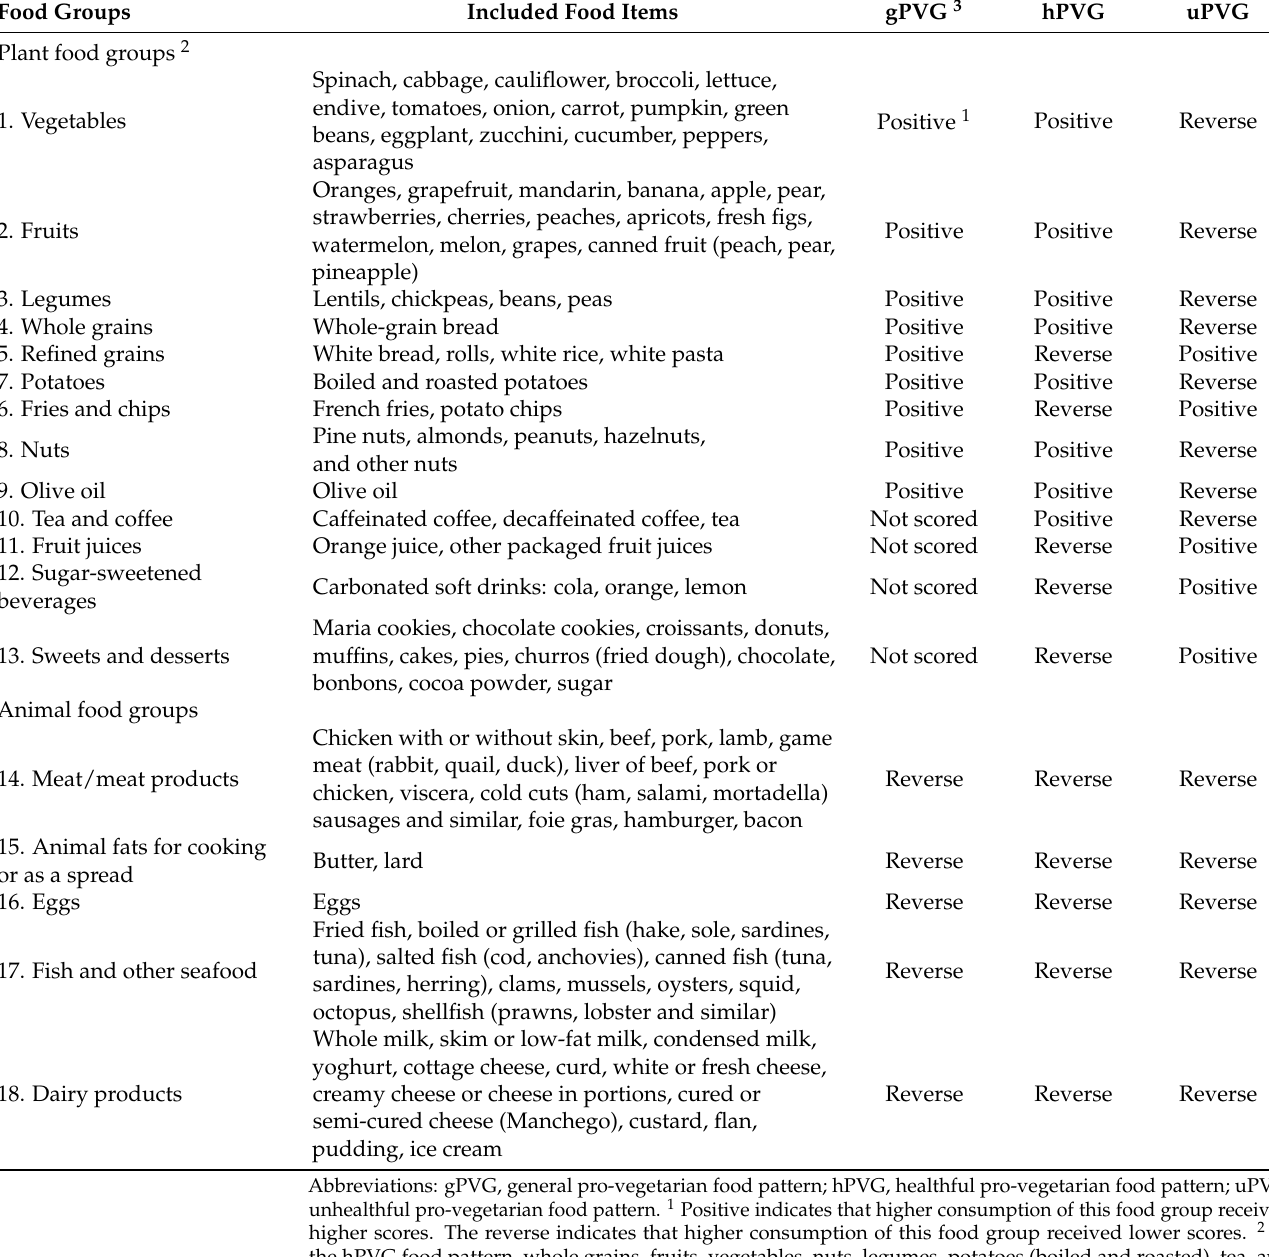
Table 1. Scoring criteria for each PVG food